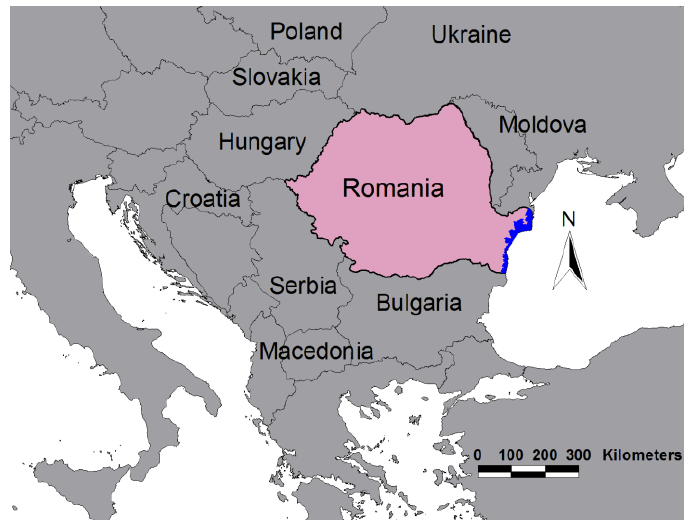
Figure 2. Location of the Romanian shoreline (blue) in Romania (purple) and Europe (gray). White areas correspond to the seas. Source: made by A.-I.P. using ESRI ArcView data.